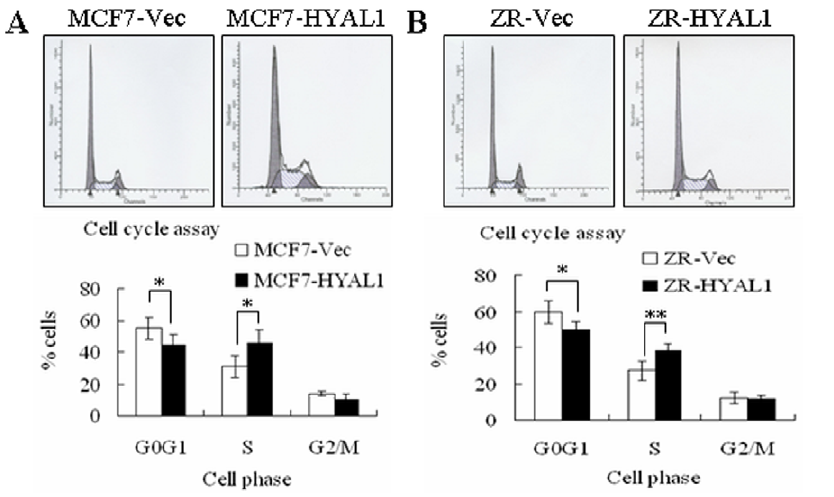
Figure 4. Upregulation of HYAL1 effected on cell cycle. The MCF7-HYAL1 (A) and ZR-HYAL1 (B) transfectants had a higher portion in S phase and a lower portion in G 0 /G 1 phase (( p , 0.05, p , 0.01, respectively)). No alterations in G 2 /M phase were observed ( p . 0.05).